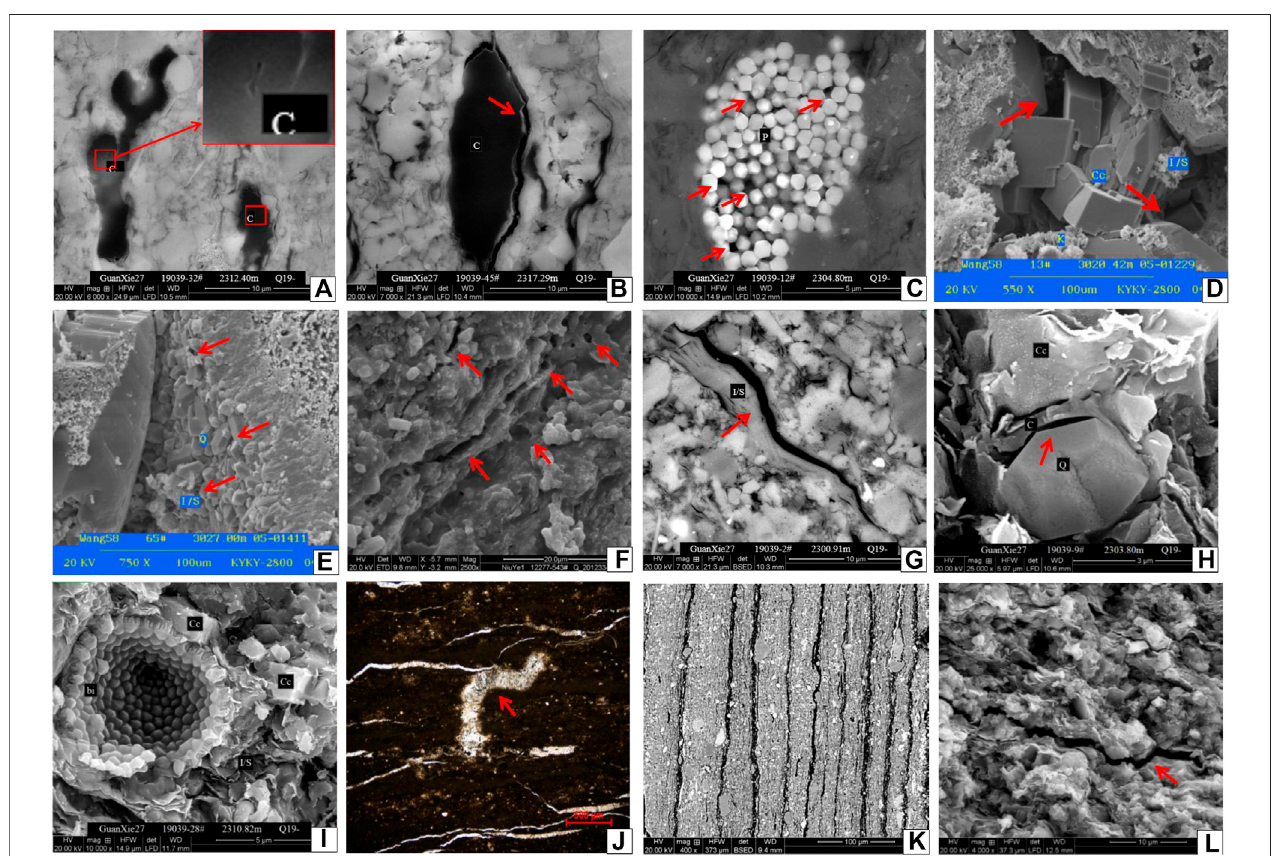
FIGURE 5 | Reservoir space types of FSR reservoirs in the study area (A) organic-matter thermal evolution shrinkage pores, GX27 Well, 2,305.85 m, 6,000x; (B) organic-matter thermal evolution shrinkage cracks, GX27 Well, 2,317.29 m, 7,000x; (C) authigenic intergranular pores in pyrites, GX27 Well, 2,310.02 m,10,000x; (D) authigenicintergranularporesincalcite,W57Well,3,419.13 m,550x; (E) authigenicintergranularporesinquartz,W58Well,3,027.00 m,750x; (F) intergranularporesof clay mineral fl occulate, NY1 Well, 3,431.93 m, 2,500x; (G) clay-mineral thermal evolution shrinkage cracks, NY1 Well, 3,437.98 m, 7,000x; (H) residual primary interparticle pores developed between calcite and quartz particles, GX27 Well, 2,303.80 m, 25,000x; (I) organism coelom pores, GX27 Well, 10,000x; (J) boring pores, almost occupied by calcite internally, T29 Well, 2,072.8 m, 5 (+); (K) bedding cracks, GX27 Well, 2,306.86 m, 400x; (L) bedding cracks existing in clay laminoid, GX27 Well, 2,316.29 m,